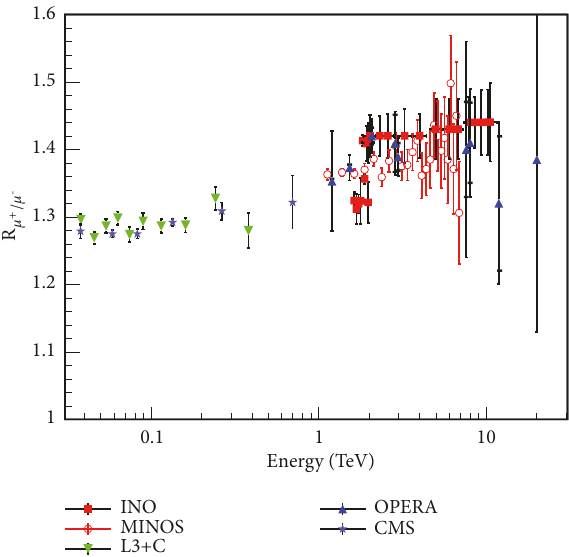
Figure 14: Muon charge ratio for a wide range of zenith angles( 𝜃 = 0 0 − 60 0 ) at INO as a function of surface muon energy and their comparison with standard existing experimental results [2–5, 7]. The charge ratio results estimated from CORSIKA are also shown in this Figure (red blocks) till 2 TeV lying in the ratio range around 1.3 to